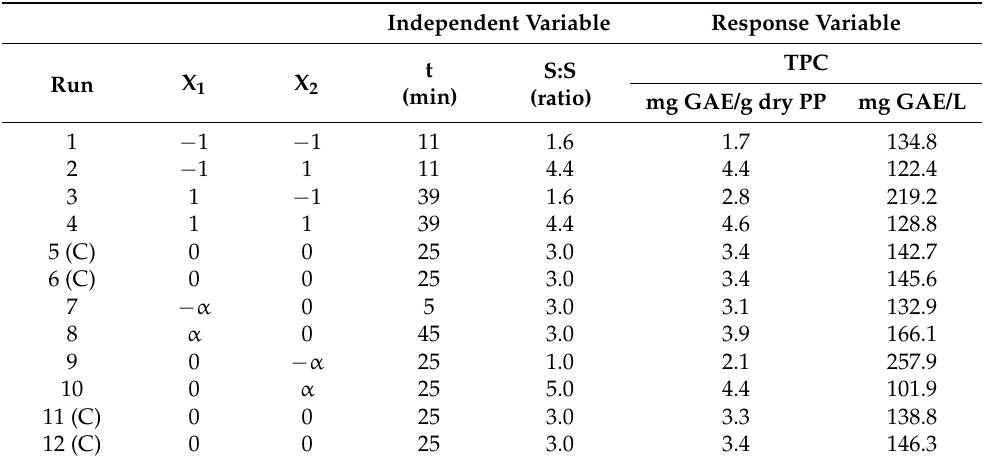
Table 1. Levels of the independent variables and total phenolic content (TPC) values. Abbreviations: t—time; S:S—solvent:pineapple peel ratio; PP—pineapple peel; GAE—gallic acid